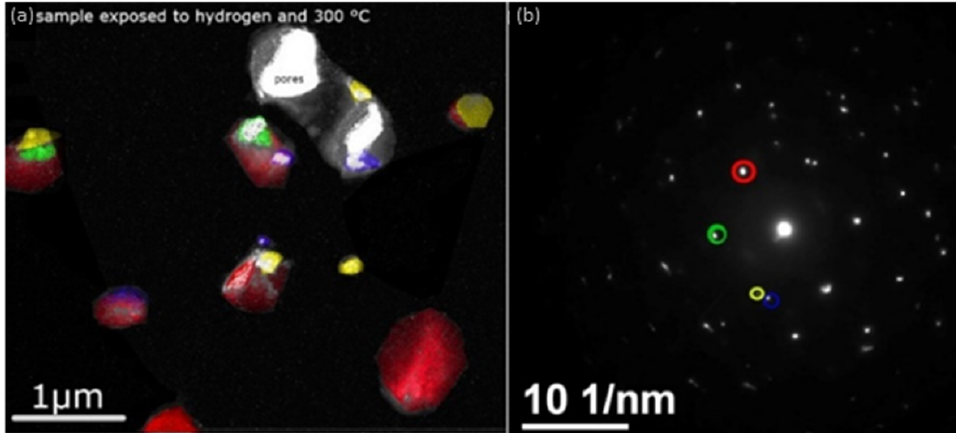
Figure 8. Superposition of dark field images of the reflection in circles for each color ( a ), Diffraction pattern with each color (shown in ( a )) indicating the different grain orientation ( b ).